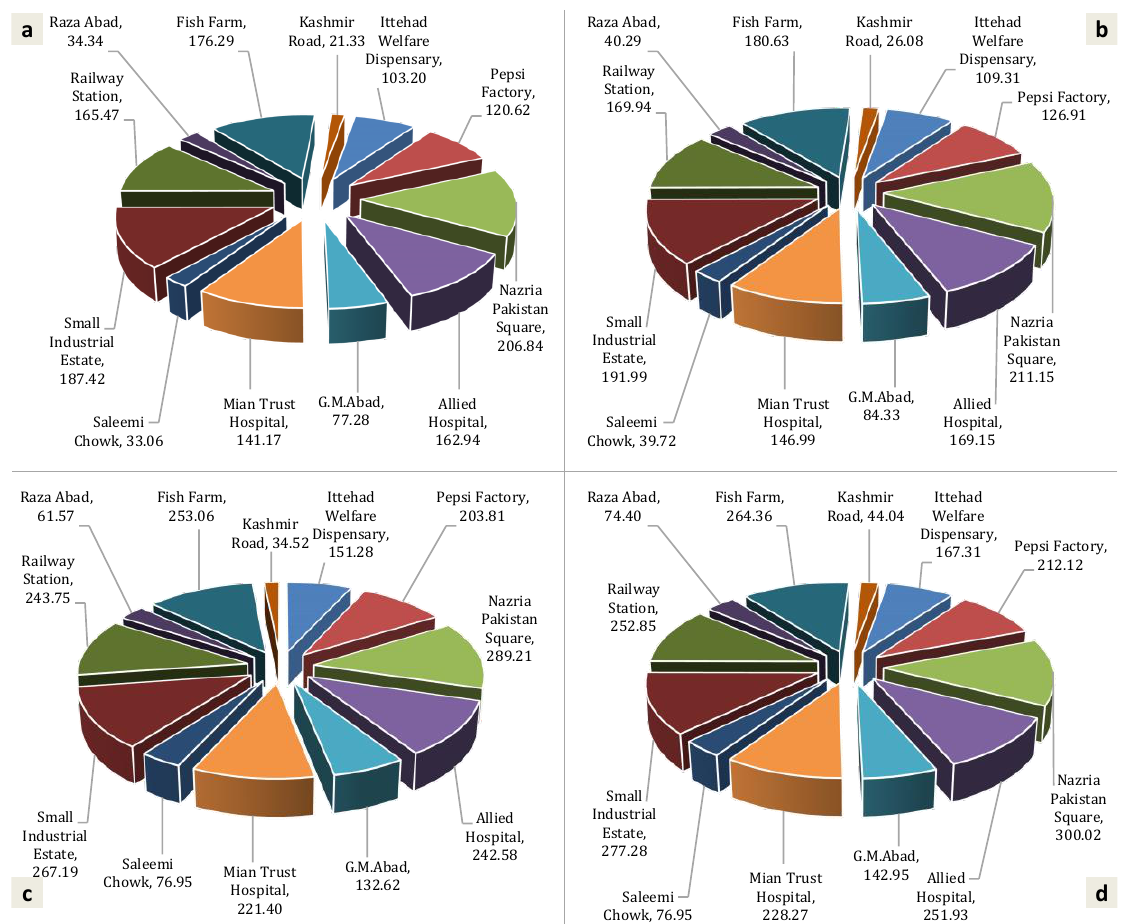
Figure 5. Concentration of carbonaceous species—total carbon (TC) in PM 2.5 in summer ( a ); PM 2.5 in winter ( b ); PM 10 in summer ( c ); PM 10 in winter ( d ). All units are expressed in μg/m 3 .